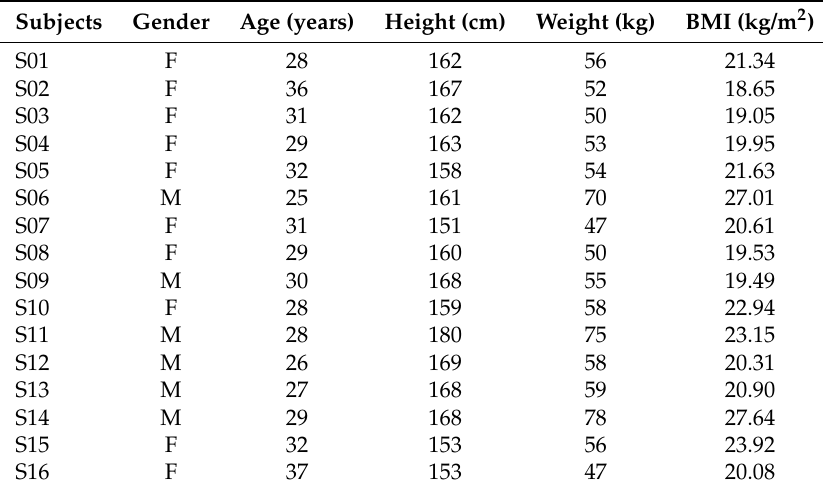
Table 2. Participants